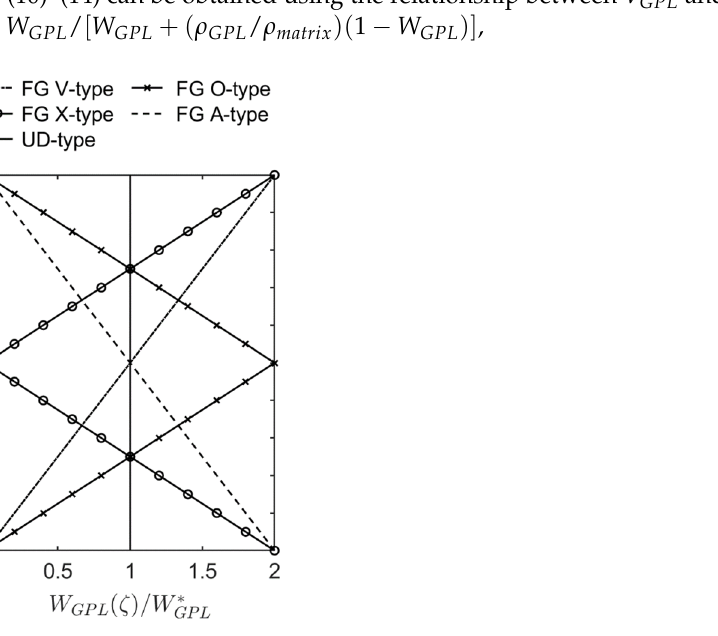
Figure 2. Five functions of GPL distribution pa tt erns varying in the thickness direction of an FG-GPLRC cylindrical microshell.